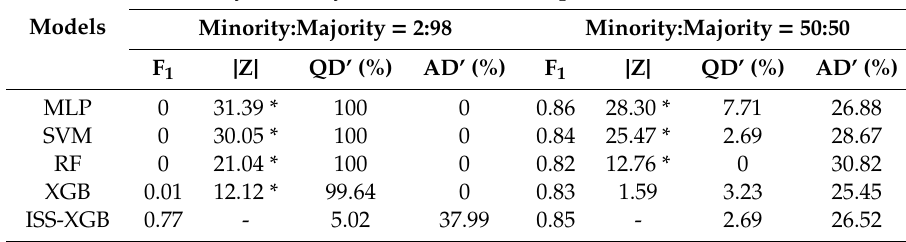
Table 2. Quantity accuracy of approaches with sample sets of di ff erent imbalances by MLP (multilayer and ISS-XGB (impartial semi-supervised learning strategy based on extreme gradient